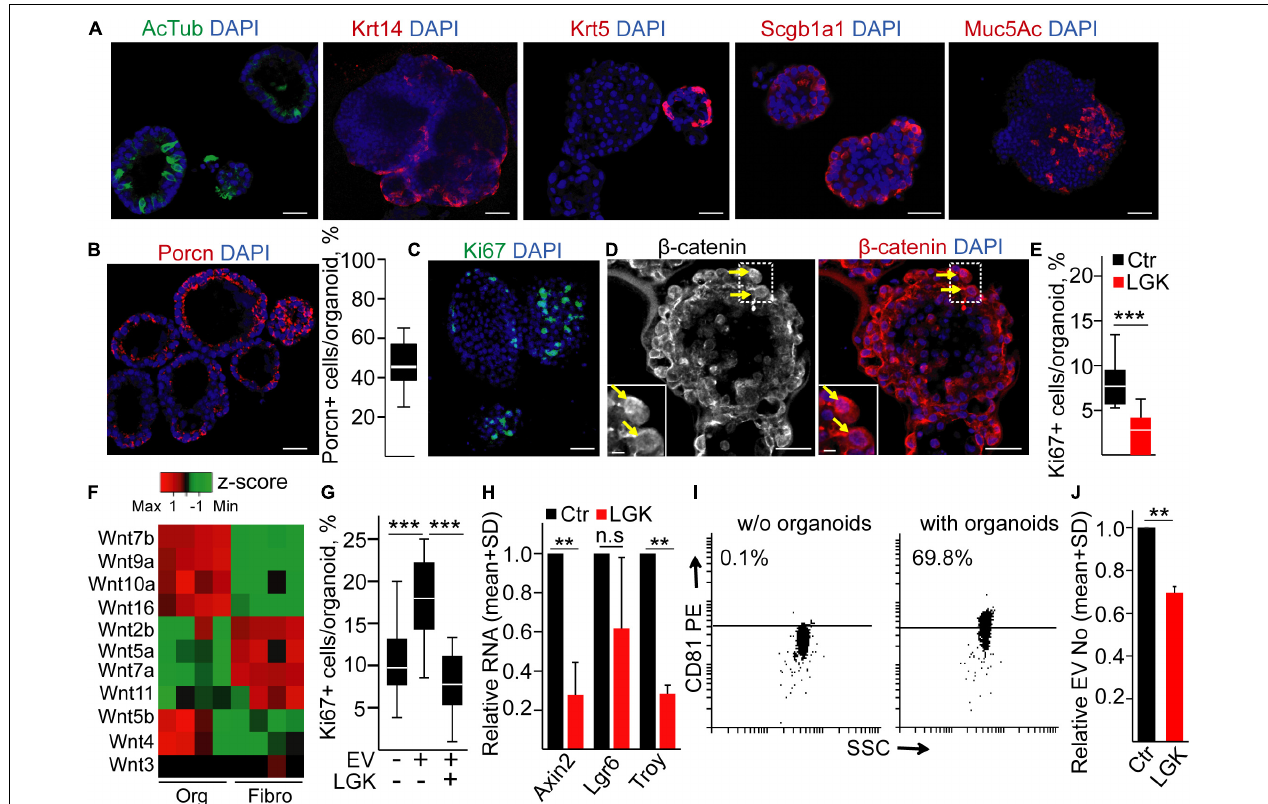
FIGURE 3 | Inhibiting Wnt secretion results in a lower proliferation and EV secretion in mouse lung bronchiolar organoids. (A) Confocal microscopic images of organoids immunostained for acetylated tubulin (AcTub), Krt14, Krt5, Scgb1a1, and Mucin5Ac (Muc5Ac). (B) Immunostaining of Porcn and the quantification of PORCN + cells in the organoids. (C,D) Detecting the Ki67+ proliferating cells and organoid cells with nuclear β -catenin (arrows). (E) The percentage of Ki67+ cells in control organoids (Ctr) or after applying the PORCN inhibitor LGK974 (LGK). (F) The expression level of the indicated Wnt genes in organoids and in mouse lung fibroblasts (RT-qPCR, n = 4). Data normalized to Hprt1 housekeeping were z -score transformed. Note that red and green colors indicate higher and lower RNA levels, respectively. (G) The percentage of proliferating cells when organoids were treated with/without lung fibroblast-derived EVs for 4 days. In some experiments, fibroblasts were pre-treated with LGK974 (LGK) 3 days before starting EV collection. (H) RNA fold changes in the organoids (compared to untreated controls) after treatment with LGK974 for Axin2 , Lgr6 , and Troy (RT-qPCR, n = 4). (I) Percentage of anti-CD81-coated positive beads after incubation in serum-free medium (w/o organoids) or in the conditioned medium derived from organoids (with organoids). Positive beads were detected with anti-CD81 (representative flow cytometry images). (J) Relative EV number after treatment of the organoids with LGK974 (NTA, n = 4). Data were normalized to 10 6 cells before comparisons. For panels (B,E,G) , data were collected from three experiments and 13–15 images were analyzed. Mann–Whitney U -test (E) , Kruskal–Wallis and Dunn tests (G) , and one-sample t -test on log10-transformed fold change data (H,J) were used with ** p < 0.01, *** p < 0.005. Scale bars: 50 µ m (A–D) and 10 µ m [ (D) , magnified